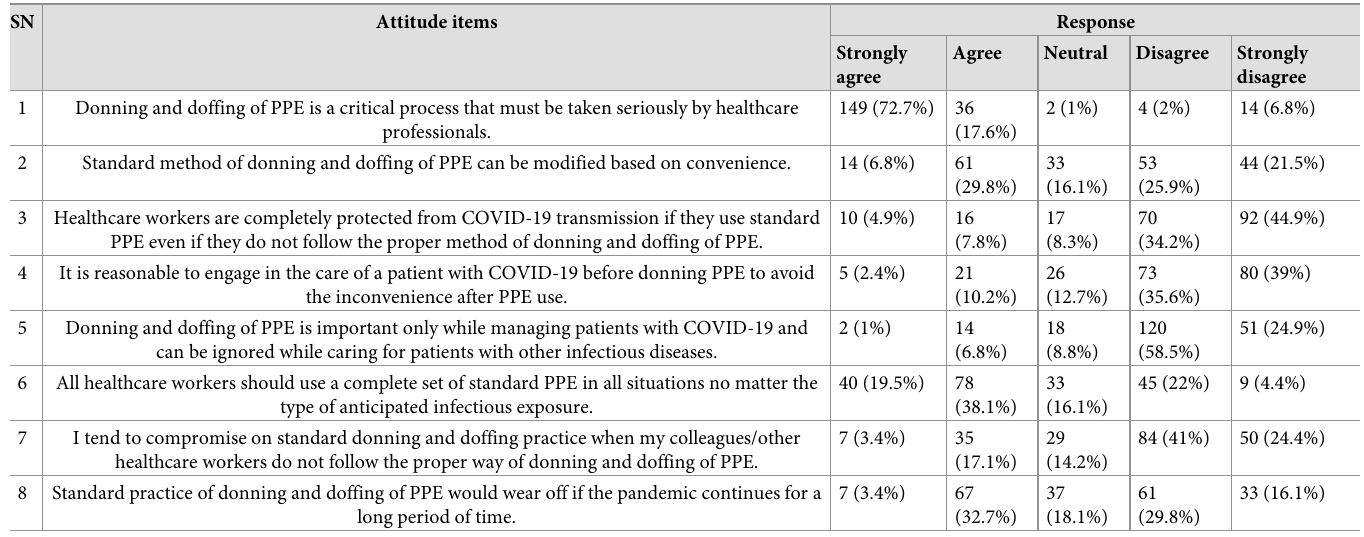
Table 6. Attitude towards components of donning and doffing of participants (n = 205).